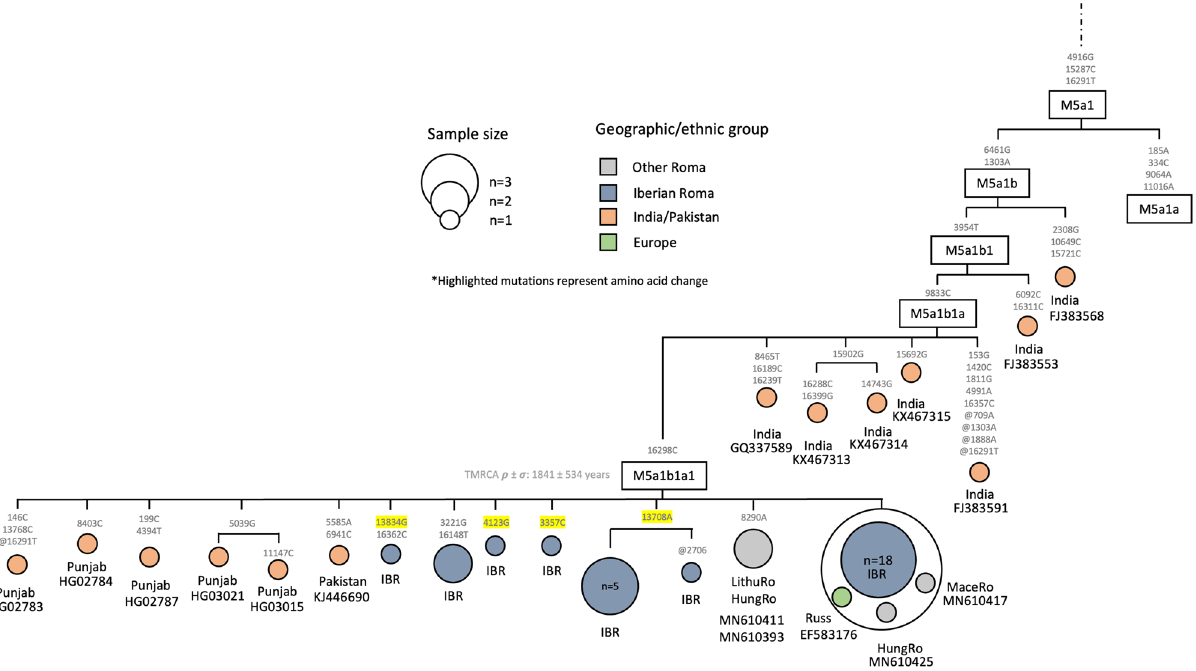
Figure 2. Maximum parsimony tree of the haplogroup M5a1b1a1 Roma mitogenomes. The mtDNA variants are indicated along the branches of the phylogenetic tree. The ‘@’ symbol represents a back mutation, and the highlighted mutations represent non-synonymous mutations. The IBR tag refers to Iberian Roma, and the ‘LithuRo’, ‘HungRo’, and ‘MaceRo’ refer to Lithuanian, Hungarian and Macedonian Roma respectively.